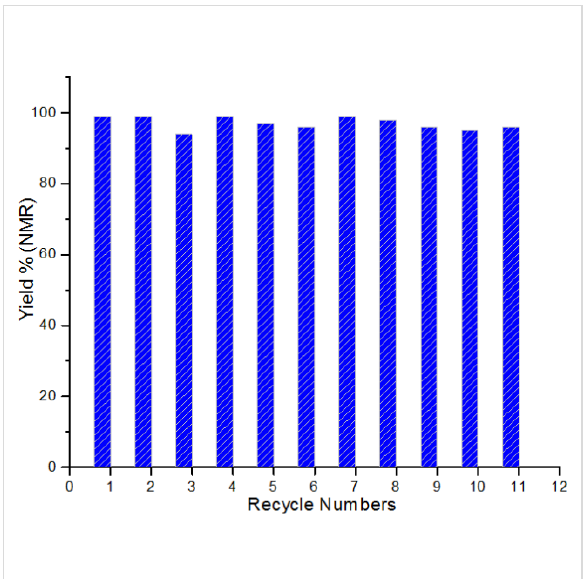
Figure 6: Recycling test of Au@HS-CNC (4.4 mol %) catalyst for the three-component coupling of formaldehyde, piperidine, and phenyl- acetylene (A 3 -coupling) under solvent-free